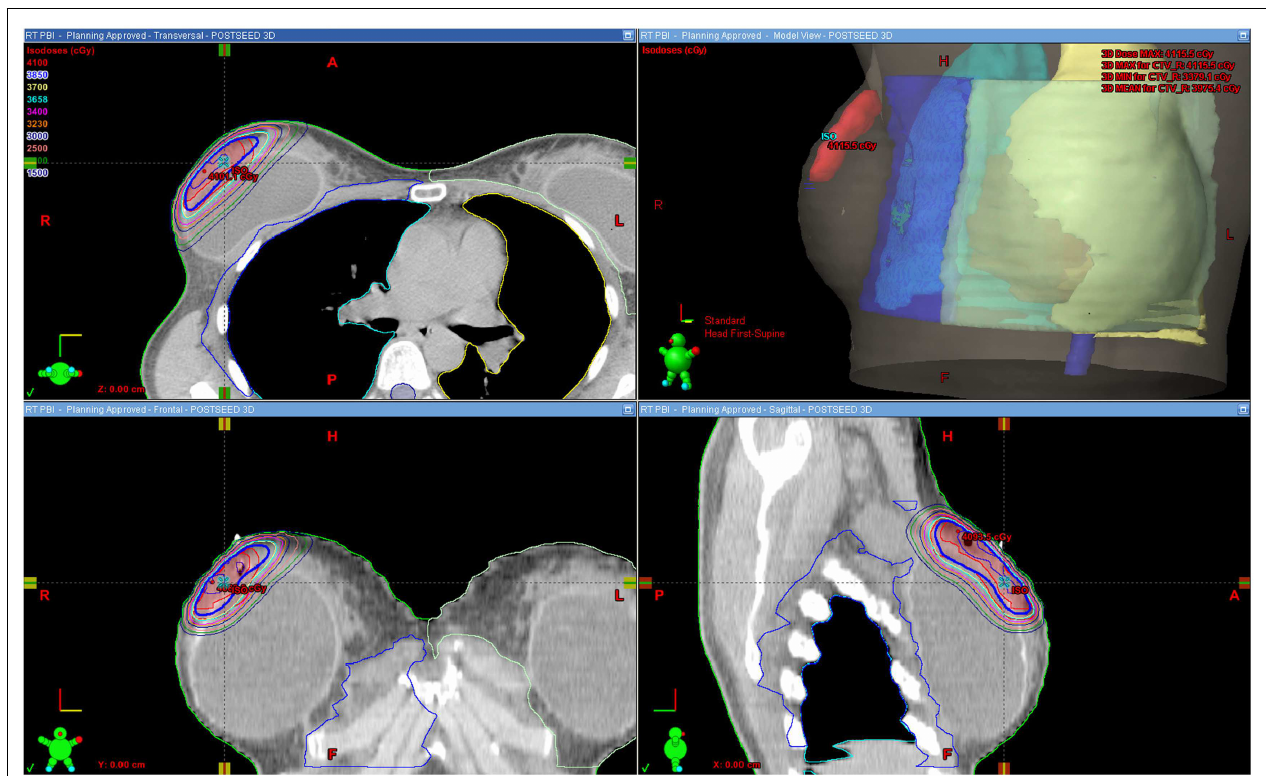
FIGURE 1 | Sample approved treatment plan